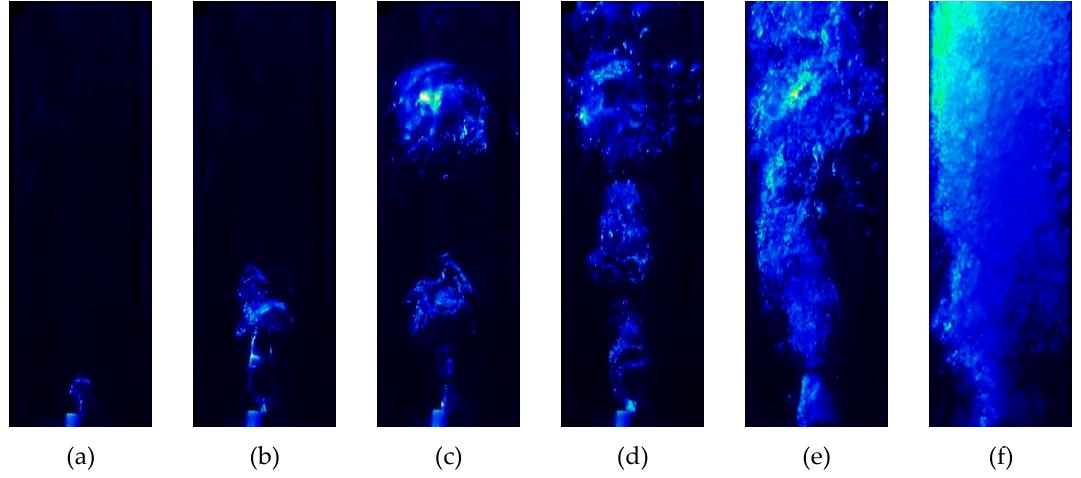
Figure 11. Bubble formation process at the nozzle. ( a ) t = 0.2 s; ( b ) t = 0.4 s; ( c ) t = 0.6 s; ( d ) t = 0.8 s; ( e ) t = 1.0 s; ( f ) t = 1.2 s.